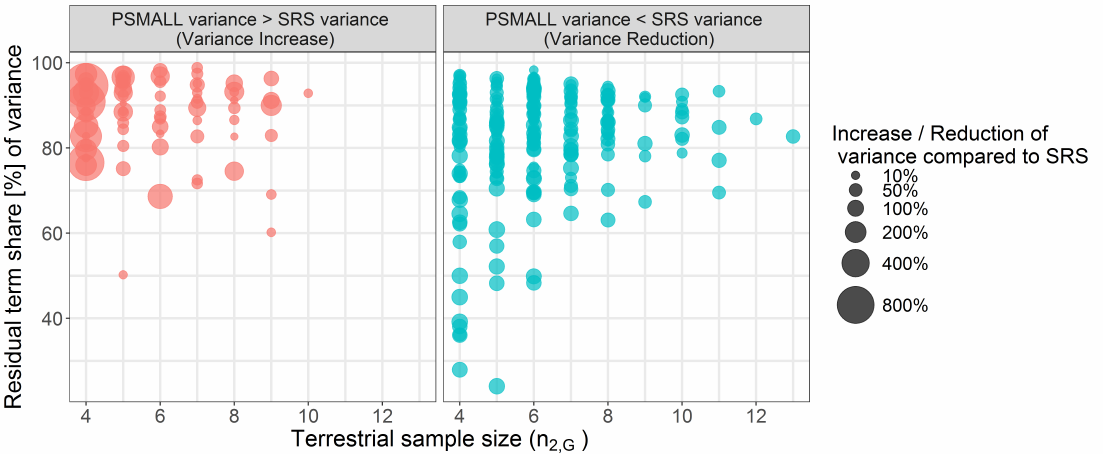
Figure 6. Share of the overall variance by the residual term of the PSMALL estimator for various small area sample sizes. Points are scaled by the overall percentage reduction/increase of the variance compared to